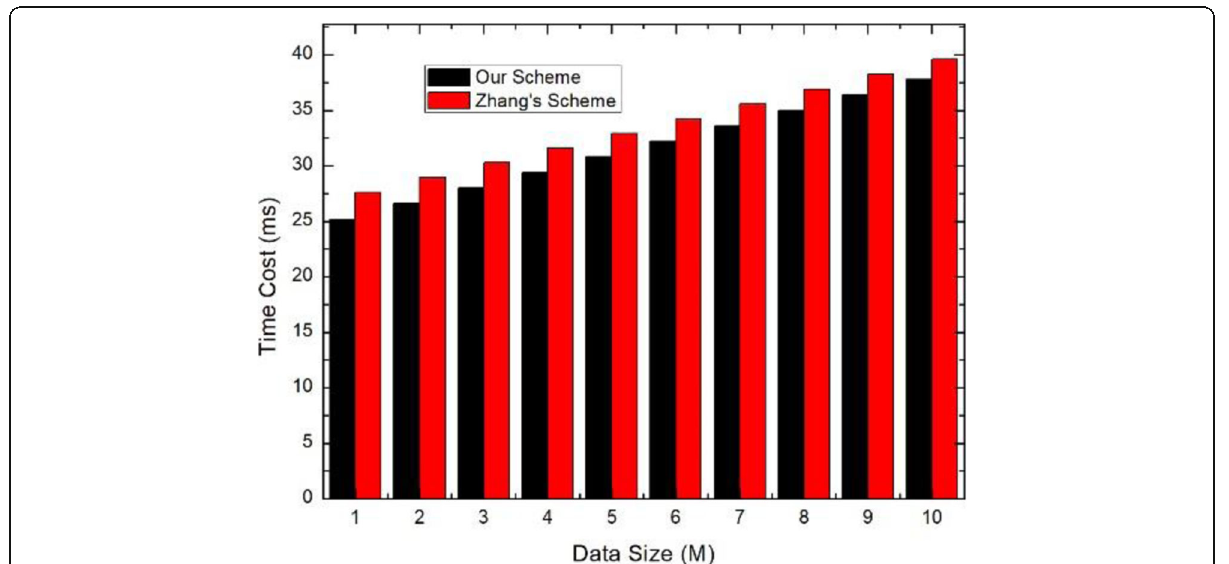
Fig. 7 Computation Time of DO with Different Size of Shared